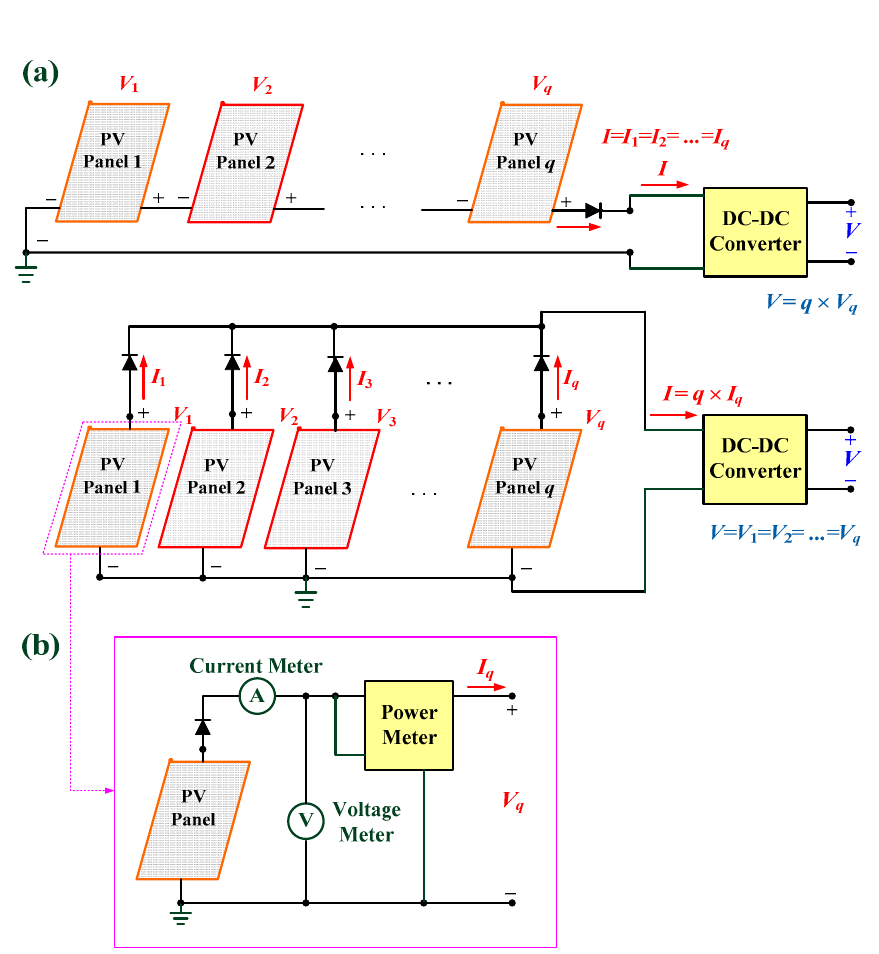
Figure 2. Schematic diagram of PV array. ( a ) PV array in a parallel or series configuration, ( b ) Measurement system of each PV panel.